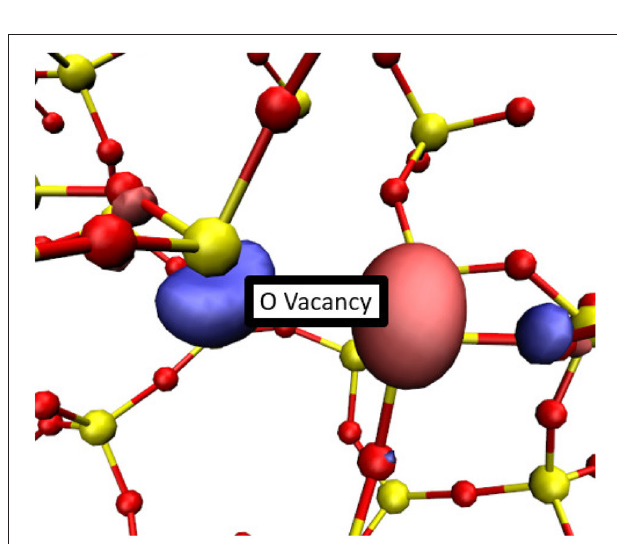
FIGURE 8 | A typical configuration of a doubly-charged O-vacancy in a-SiO 2 . Two electrons have been trapped at this vacancy and the Si atoms within the vacancy pivot to point away from each other. Si atoms are shown in yellow while O atoms are shown in red. An iso-surface of the HOMO is shown in blue and